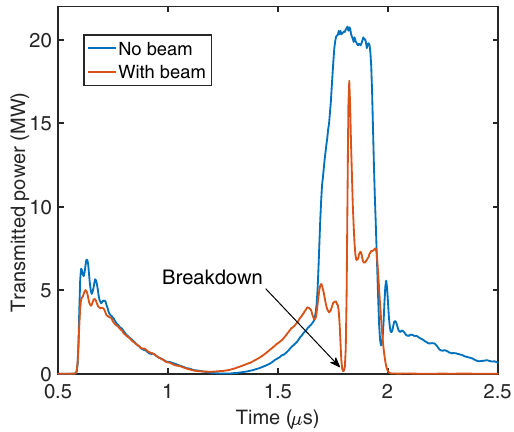
FIG. 9. Transmitted power for a reference signal during normal operation without beam (in blue), and the highest transmitted power registered in a breakdown event during operation with beam (in red). In both cases the input power is 43.3 MW. The difference in the initial part of the pulse is due to a different tuning of the pulse